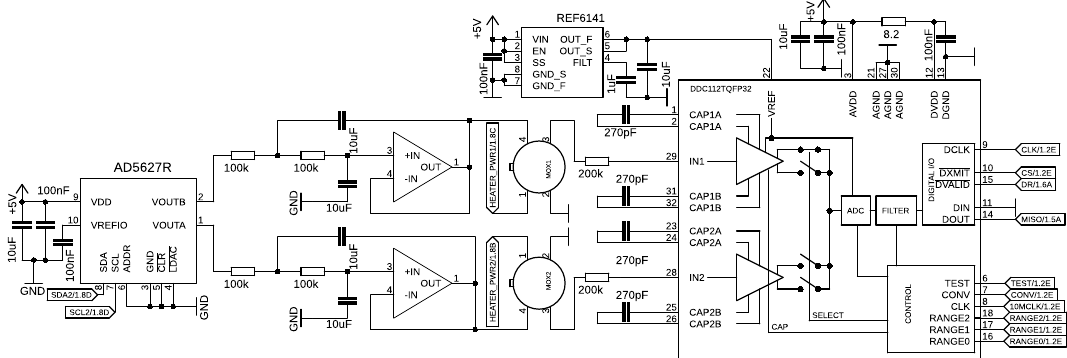
Figure 3. Schematic depicting (from left to right) the user-programmable sensor excitation voltage block (AD5627R with active low-pass filtering), two MOX sensors, the reference generator REF6141, and the DDC112